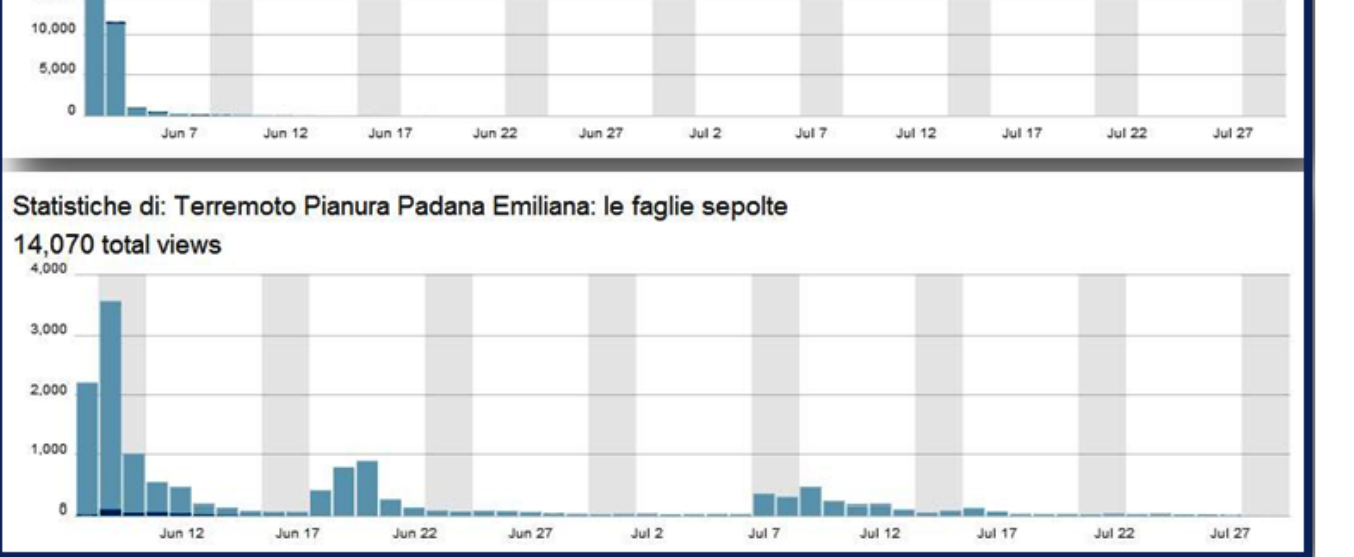
Figure 3. (a) The number of daily contacts of the static page 'Seismic monitoring' ( Il monitoraggio sismico ), during the first two months (May 29 to July 29, 2012). (b) The number of daily contacts of the post published soon after the June 3, 2012, M was the peak in the number of visits, which was more than 857,000. (c) The number of daily contacts of the post 'Buried faults' ( Le faglie sepolte ), which was published on June 8, 2012. This post represents in-depth